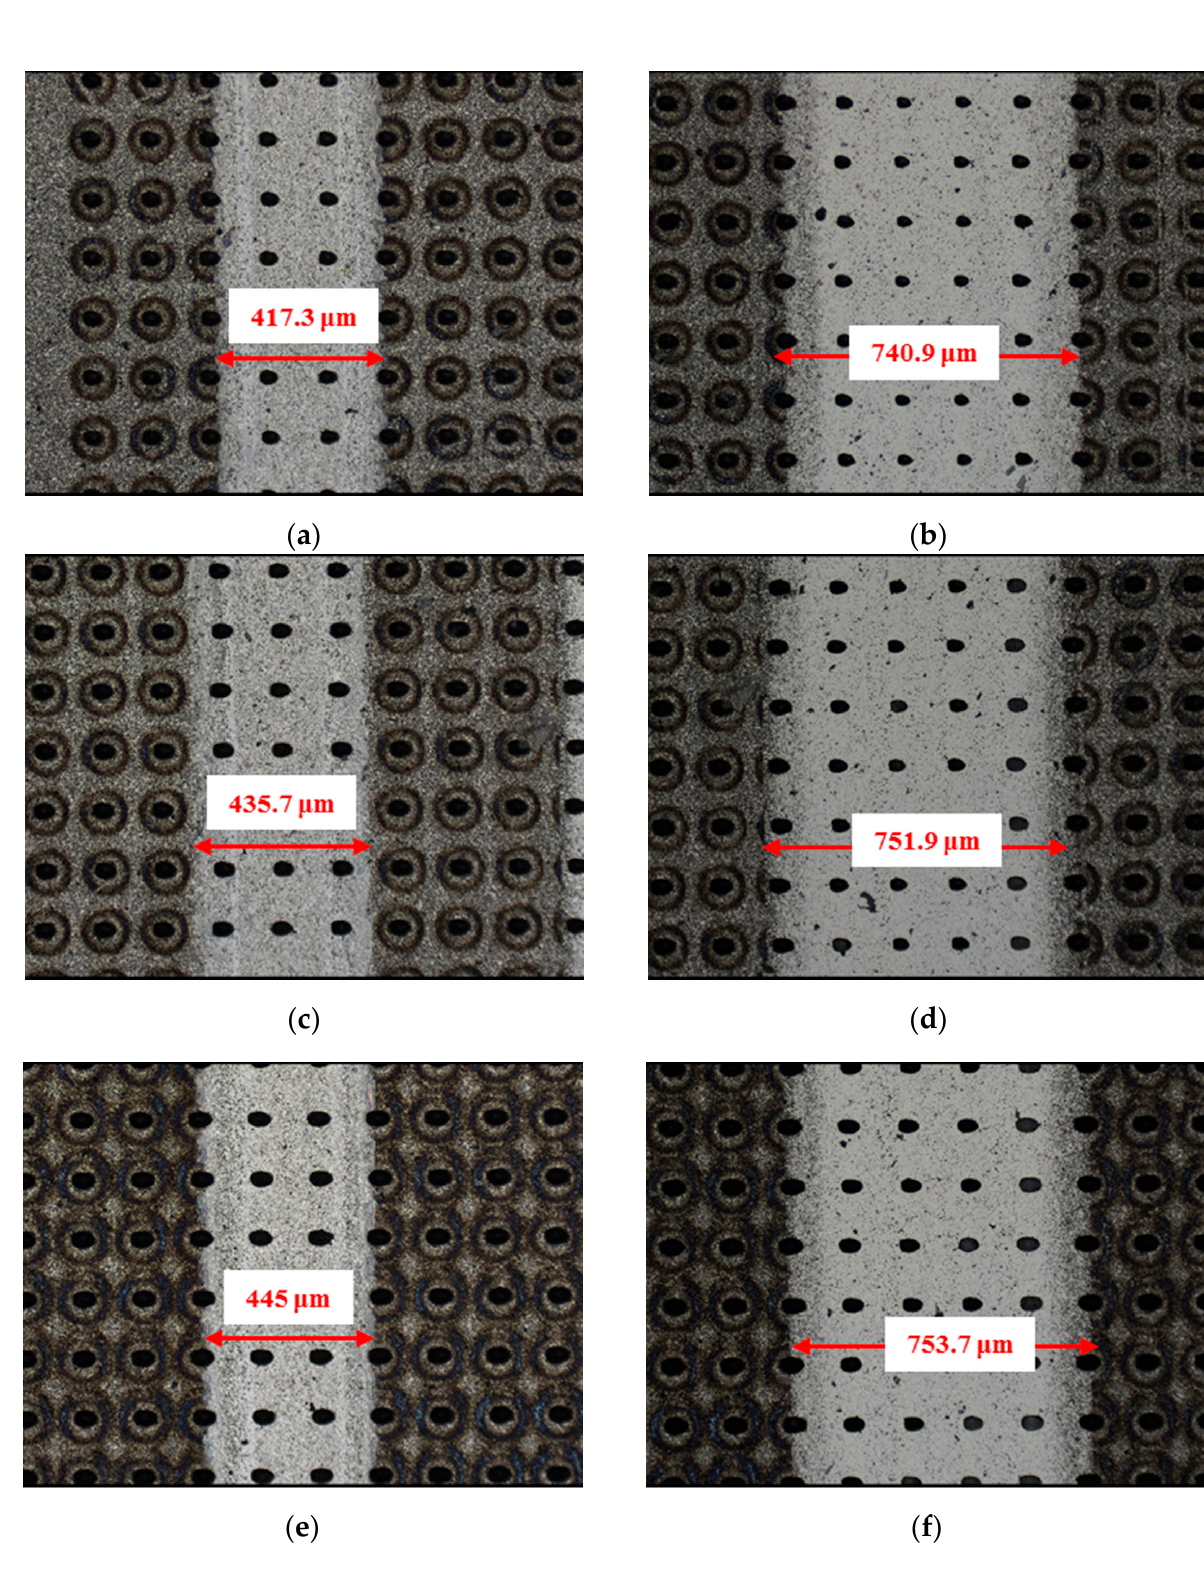
Figure 16. Wear performance of circular-dimple-textured SiC under water-lubricated conditions with a load of 75 N (×10): ( a ) 3 µ m circular-dimple-textured SiC–steel ball, ( b ) 3 µ m circular-dimple-textured SiC–Si 3 N 4 ball, ( c ) 5 µ m circular-dimple-textured SiC–steel ball, ( d ) 5 µ m circular-dimple-textured SiC–Si 3 N 4 ball, ( e ) 10 µ m circular-dimple-textured SiC–steel ball, and ( f ) 10 µ m circular-dimple-textured SiC–Si 3 N 4 ball.